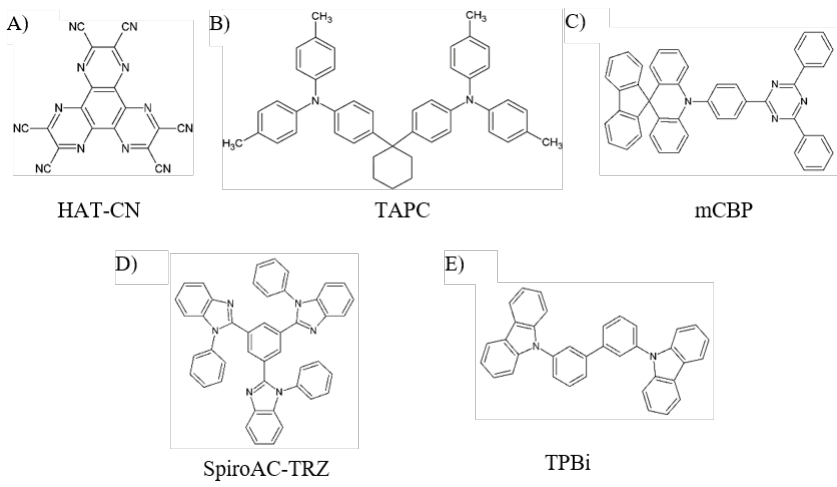
Figure 3. Molecule structure of organic materials: ( A ) HAT-CN, ( B ) TAPC, ( C ) mCBP, ( D ) SpiroAC-TRZ, ( E )